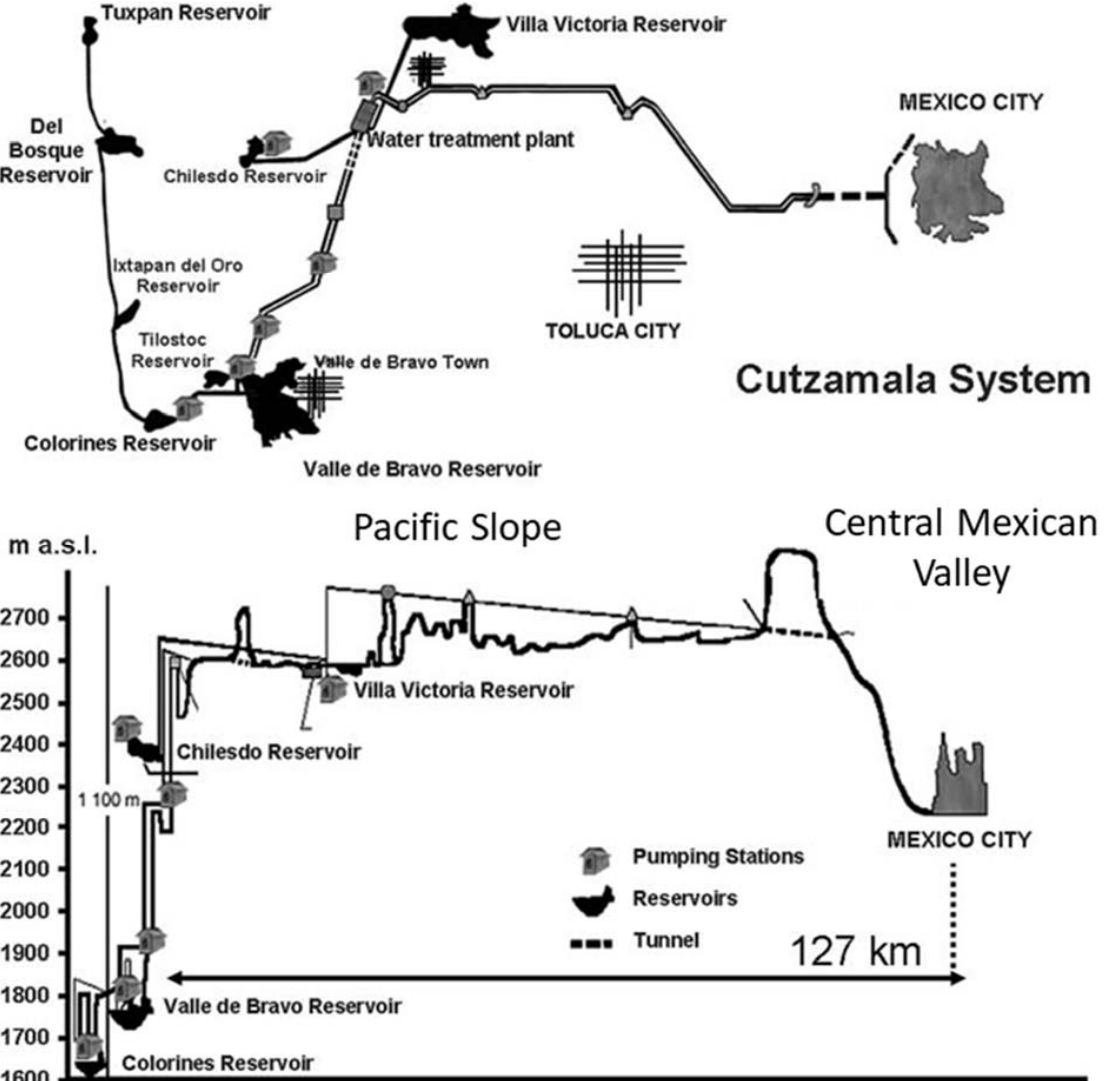
Figure 1. The Cutzamala System. Outline and distribution of the reservoirs ( top ). Altitude profile ( bottom ) showing the location of the reservoirs on the Pacific slope, east of the Central Mexican Valley where Mexico City is located. Modified from Ramírez-Zierold et al. (2010).